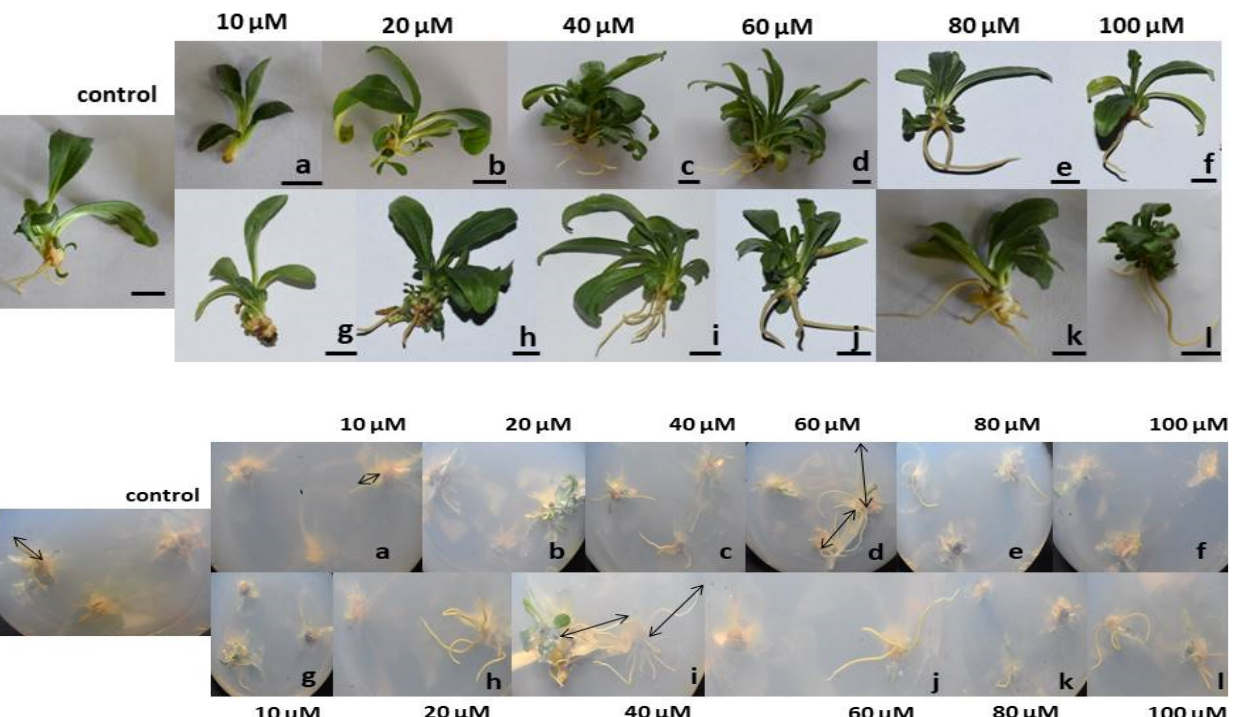
Figure 1. Characterization of the AuNPs. ( a ) UV–Vis absorption spectra of the synthesized citrate- AuNPs and CTAB-AuNPs (insets are the digital photographs of the corresponding AuNPs). ( b , d ) DLS and ( c , e ) zeta potentials of the citrate-AuNPs and CTAB-AuNPs, respectively. ( f , g ) The TEM micrographs (top-right insets are the SAED patterns, bottom-left insets are the TEM size distribution